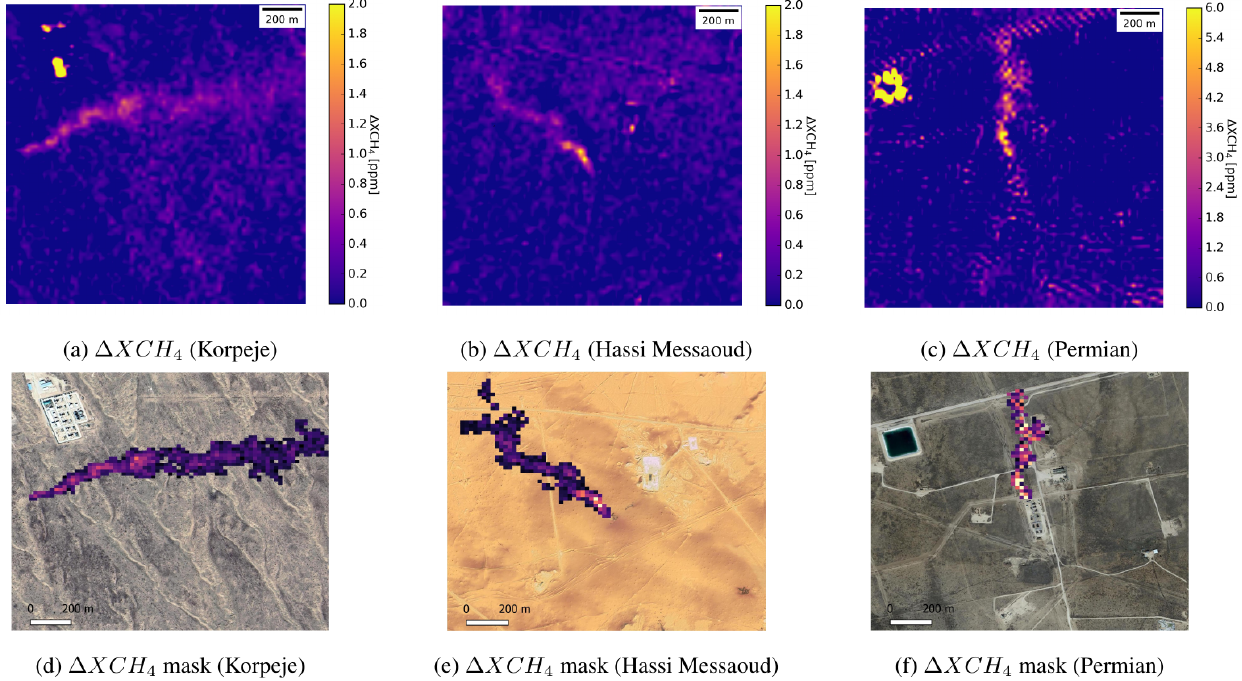
Figure 6. (cid:49)X CH maps for the known methane point sources in Korpeje (a) , Hassi Messaoud (b) , and Permian Basin (c) O&G production 4 regions. Panels (d) , (e) and (f) background map from © Google Earth and © Microsoft